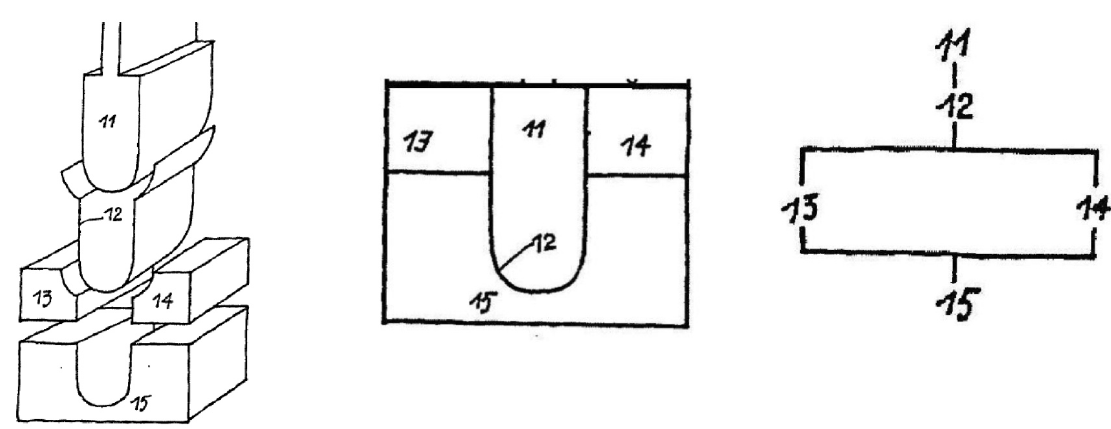
Figure 2. Different representations of Unit of Stratigraphication (US) relations, cited from ([37], p. 83). Earlier software such as ABC FlowCharter 4.0 (originally from Micrografx, in 1995 and then